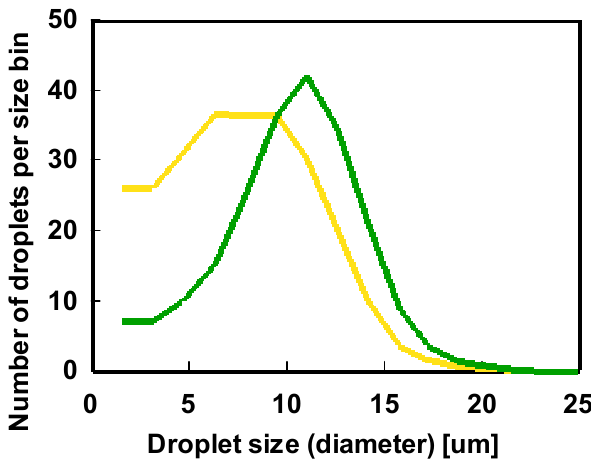
Fig. 6. Droplet size distributions over agriculture (yellow) and natu- ral vegetation (green). Both droplet spectra do not reach the thresh- old for precipitation